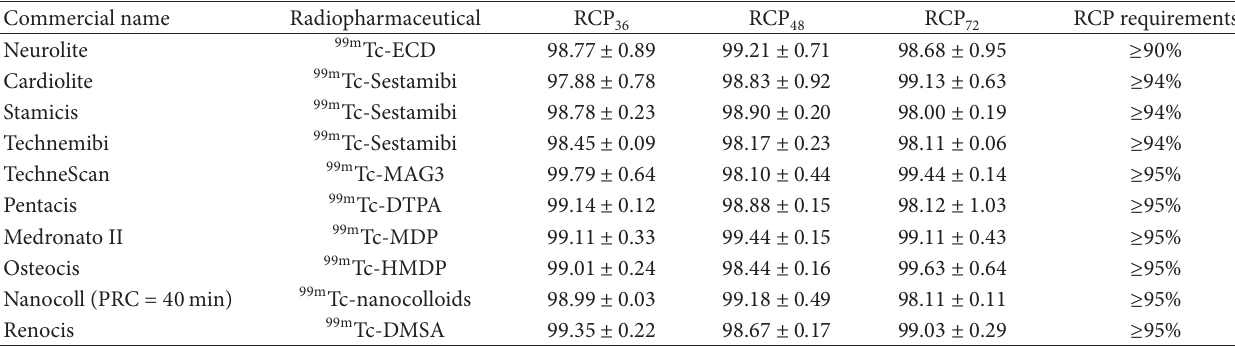
Table 4: RCP of radiopharmaceuticals at 𝑡 = 0 , prepared with generator Elumatic III (IBA) eluates at time superior to 24h from the last elution.